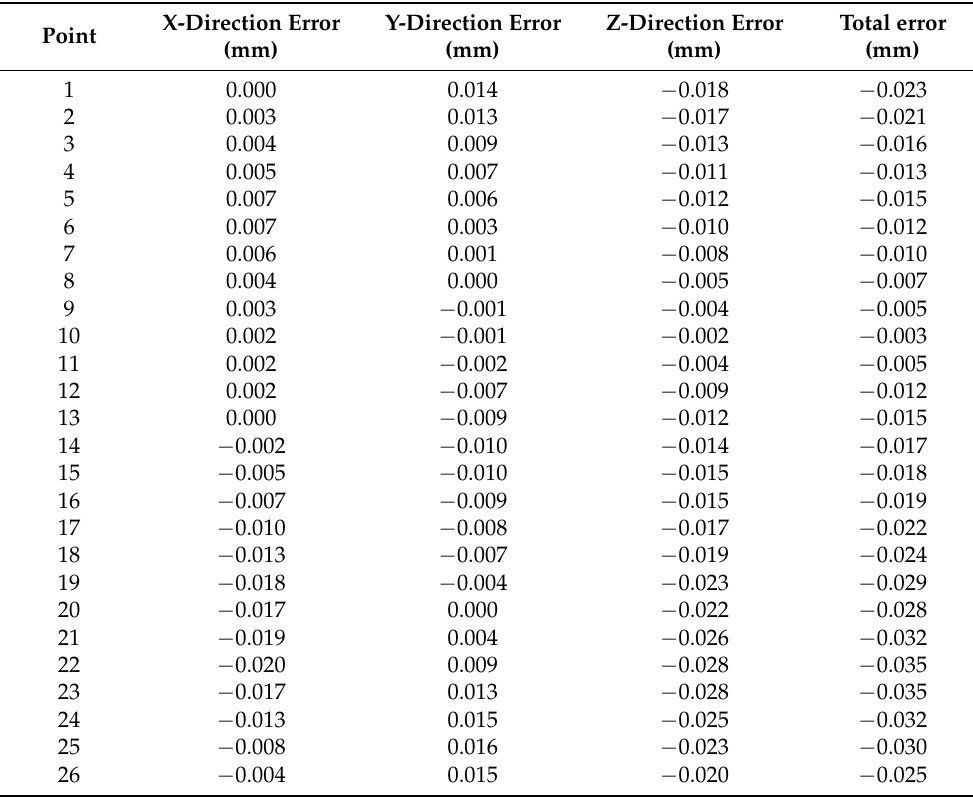
Table 3. Date of the error of each